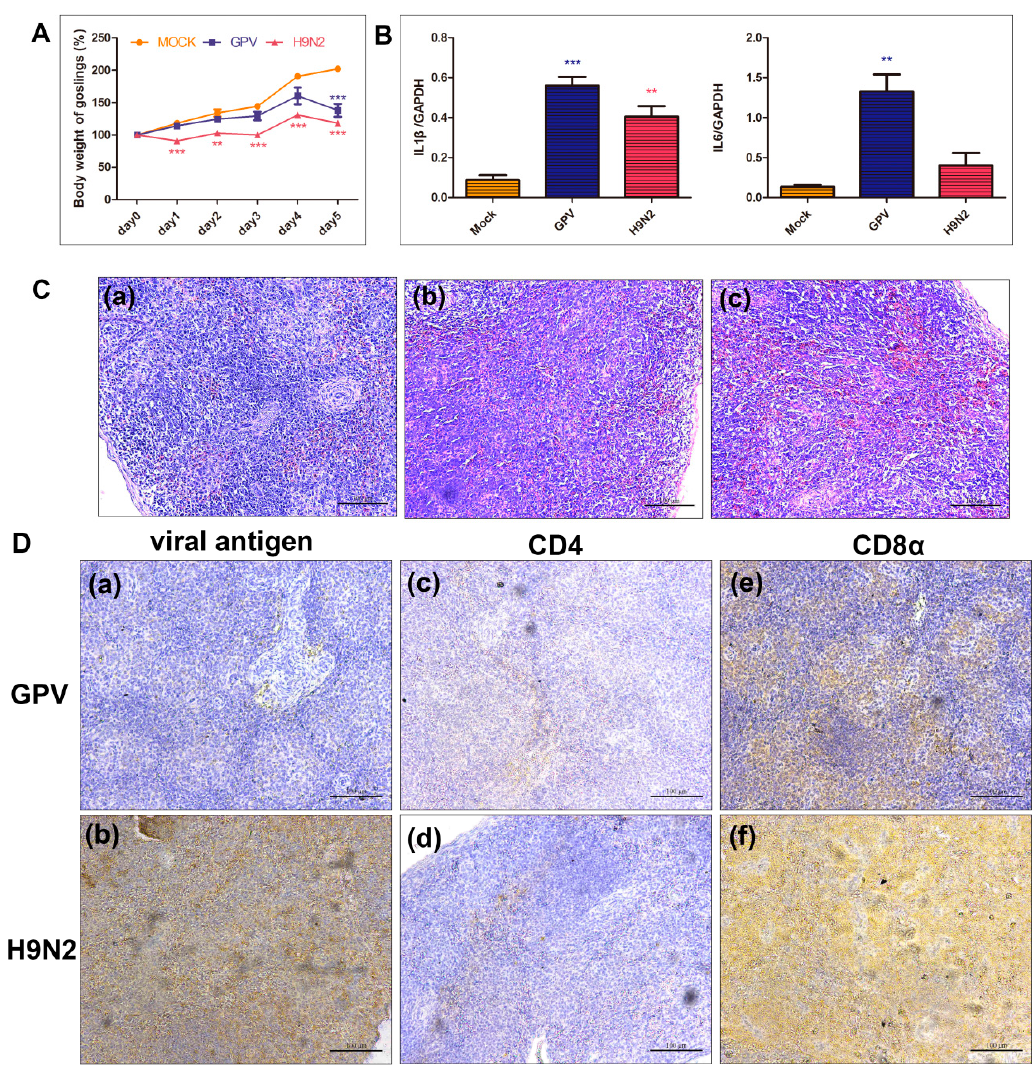
Figure 1. Global characteristics of goslings after infection with GPV and H9N2. ( A ) Body weight change of GPV- and H9N2-infected goslings from day 0 to 5. ** p ≤ 0.01, *** p ≤ 0.001; ( B ) the expression level of IL-1 β and IL-6 in the spleen tissues of GPV- and H9N2-infected goslings. ** p ≤ 0.01, *** p ≤ 0.001; ( C ) histological changes in goose spleens infected with GPV and H9N2 at 5 dpi. The spleen tissues from ( a ) mock-, ( b ) GPV-, and ( c ) H9N2-infected goslings were stained with H &E, and diffuse hemorrhage was observed in either of virus-infected spleen sections, scale bar = 100 µm; and ( D ) Detection of ( a ) GPV and ( b ) H9N2 antigen, as well as ( c , d ) CD4- and ( e , f ) CD8 α -positive cells by immunohistochemical analysis. The dark brown represents positive signs for viral antigen, CD4, or CD8 α molecules, scale bar = 100 µm.